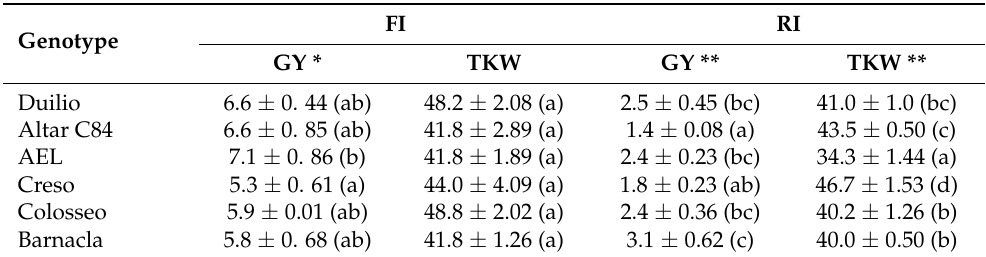
Table 3. Grain yield (GY) in ton/ha and thousand kernel weight (TKW) in g observed for the six durum wheat genotypes, evaluated under full (FI) and reduced (RI) irrigation conditions. Data reported are means ± standard deviations.; * p < 0.05; ** p < 0.01.